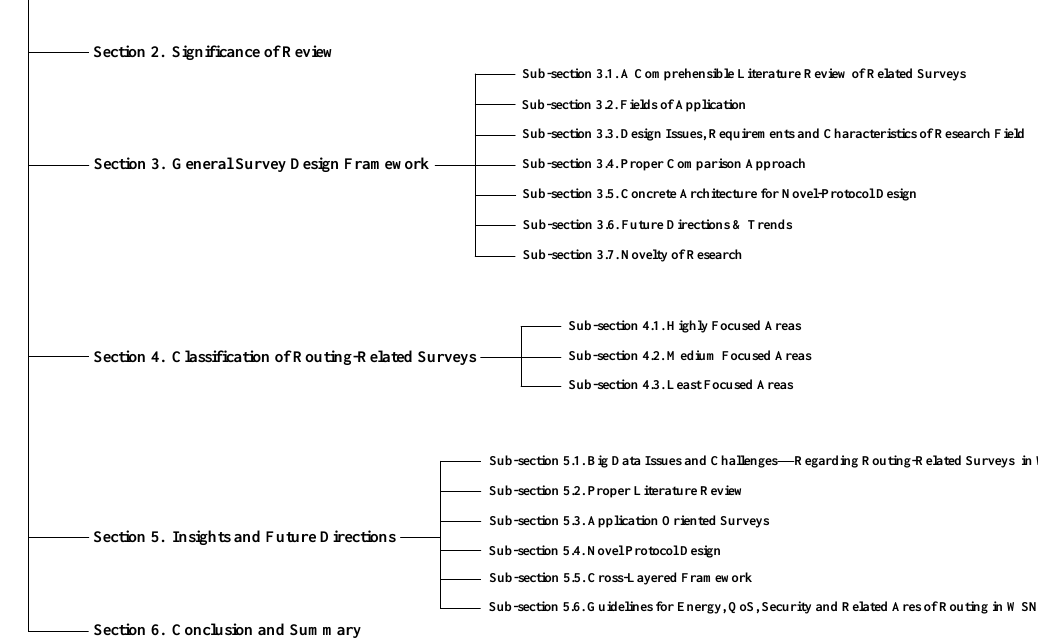
Figure 1. Organization of